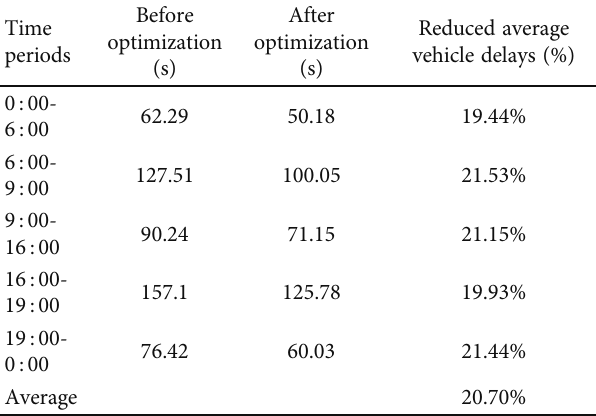
Table 5: Comparison of model result between before and after optimization.